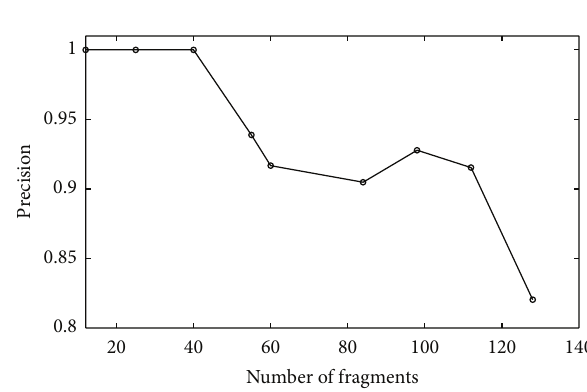
Figure 15: The precision of reconstructing another document shredded into different